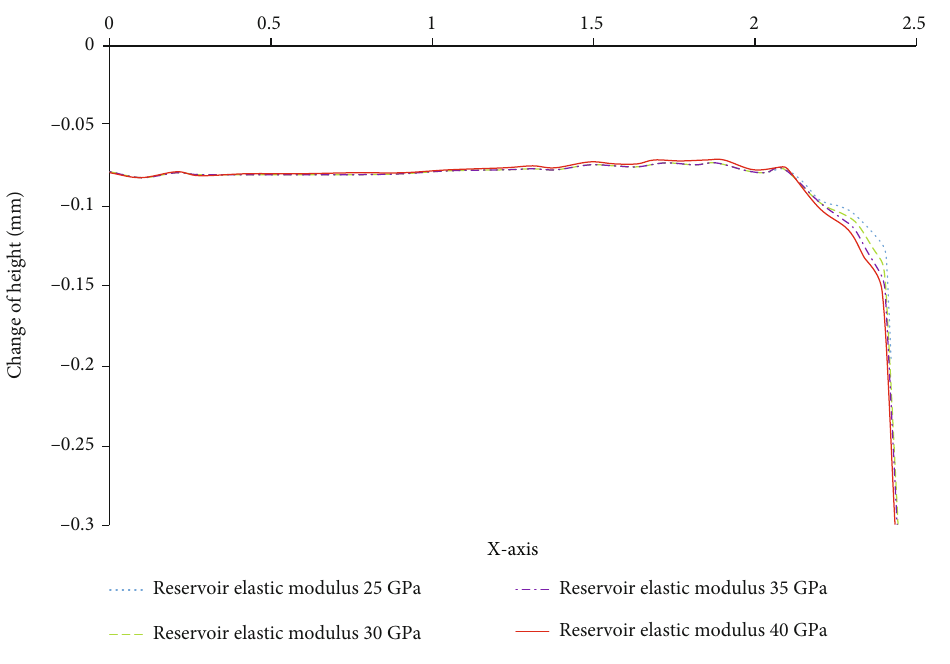
Figure 36: The height change of proppant under di ff erent elastic moduli (in situ stress 60 MPa).